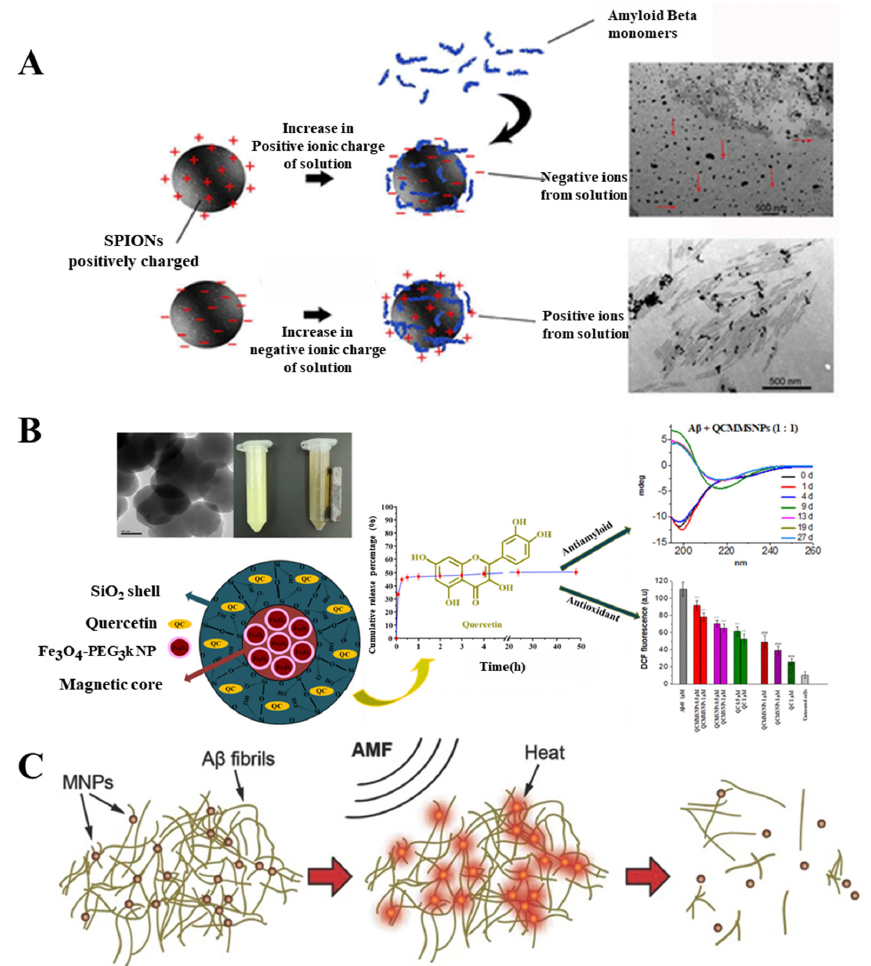
Figure 7. ( A ) Schematic of the influence of the physiochemical properties of SPIONs on A β